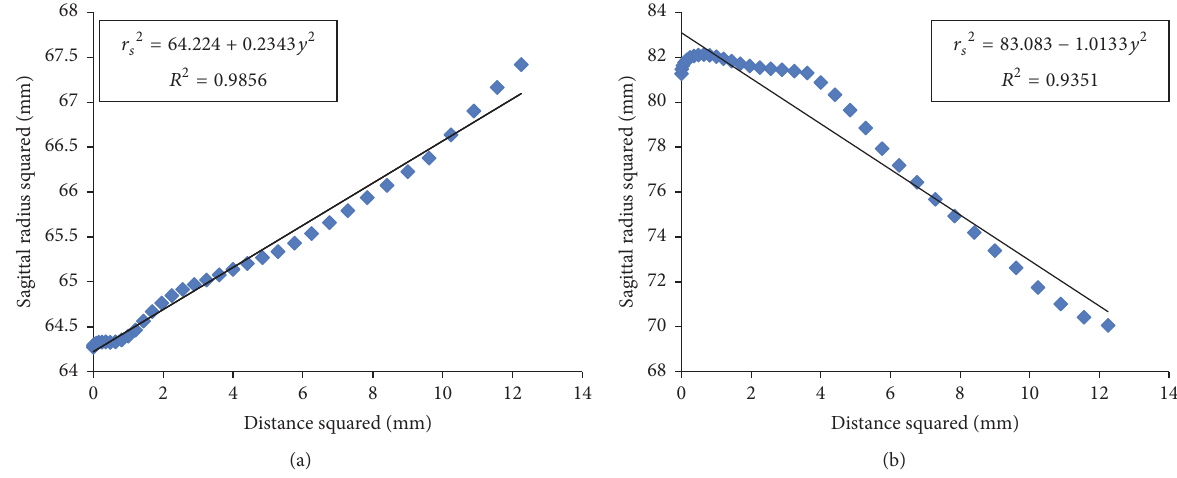
Figure 2: Scatterplot of sagittal radius squared ( 𝑟 𝑠2 ) versus distance squared ( 𝑦 2 ) in the nasal flat principal semimeridian of the right eye for the same subject before (a) and after surgery